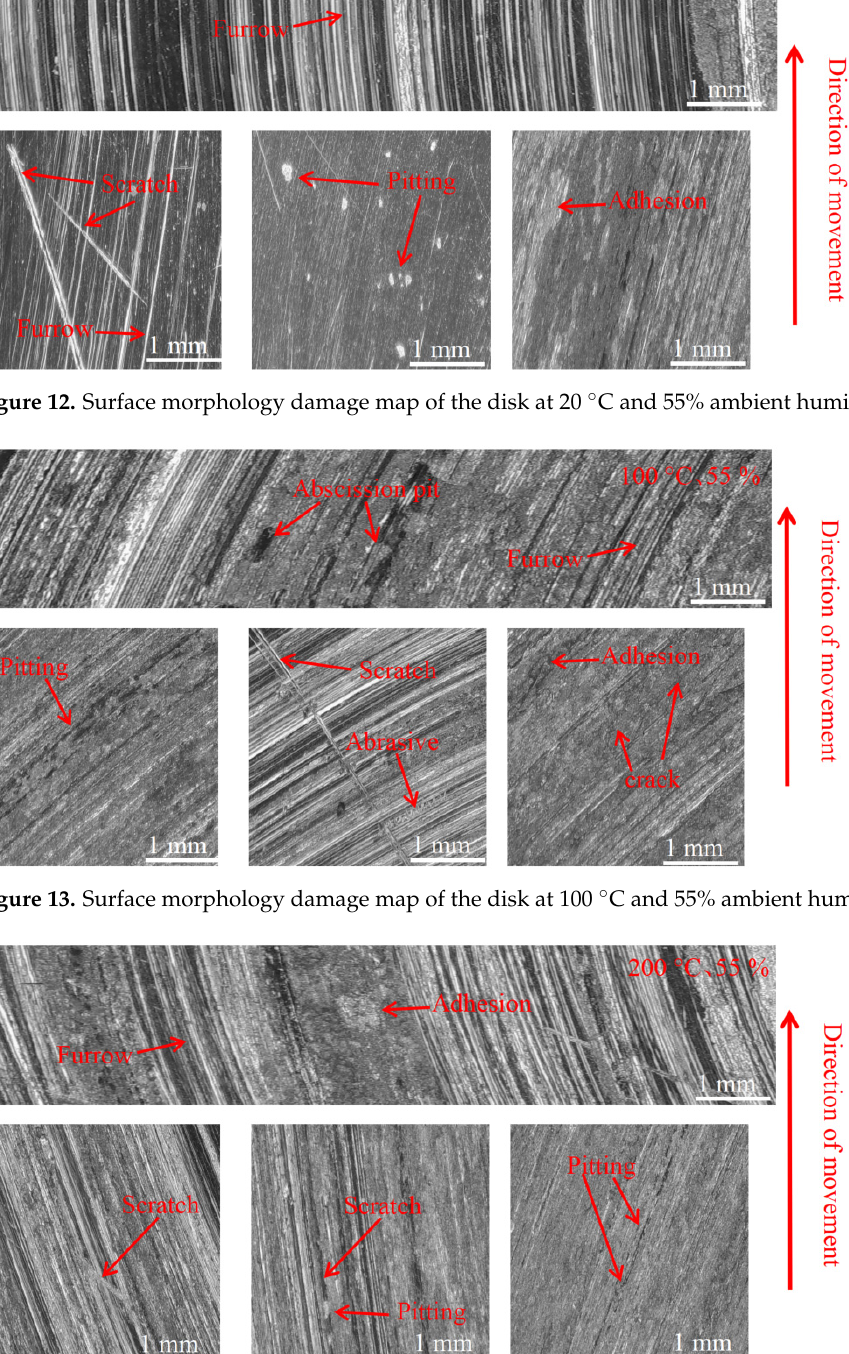
◦ C and 55% ambient